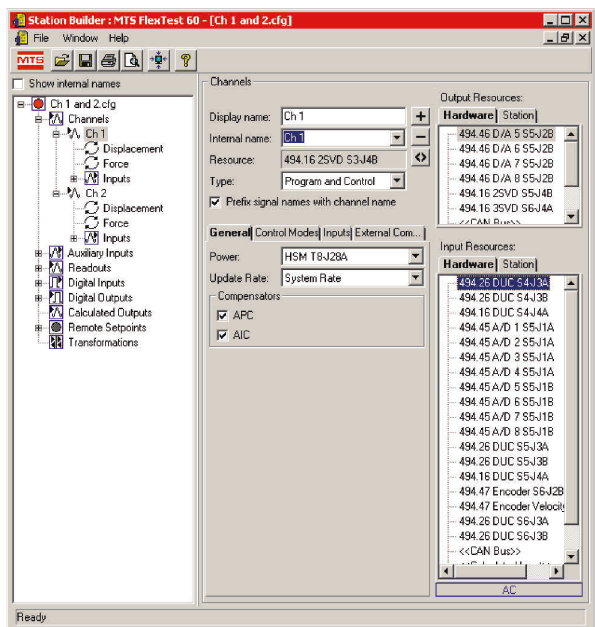
Figure 4: Interface of the station builder.